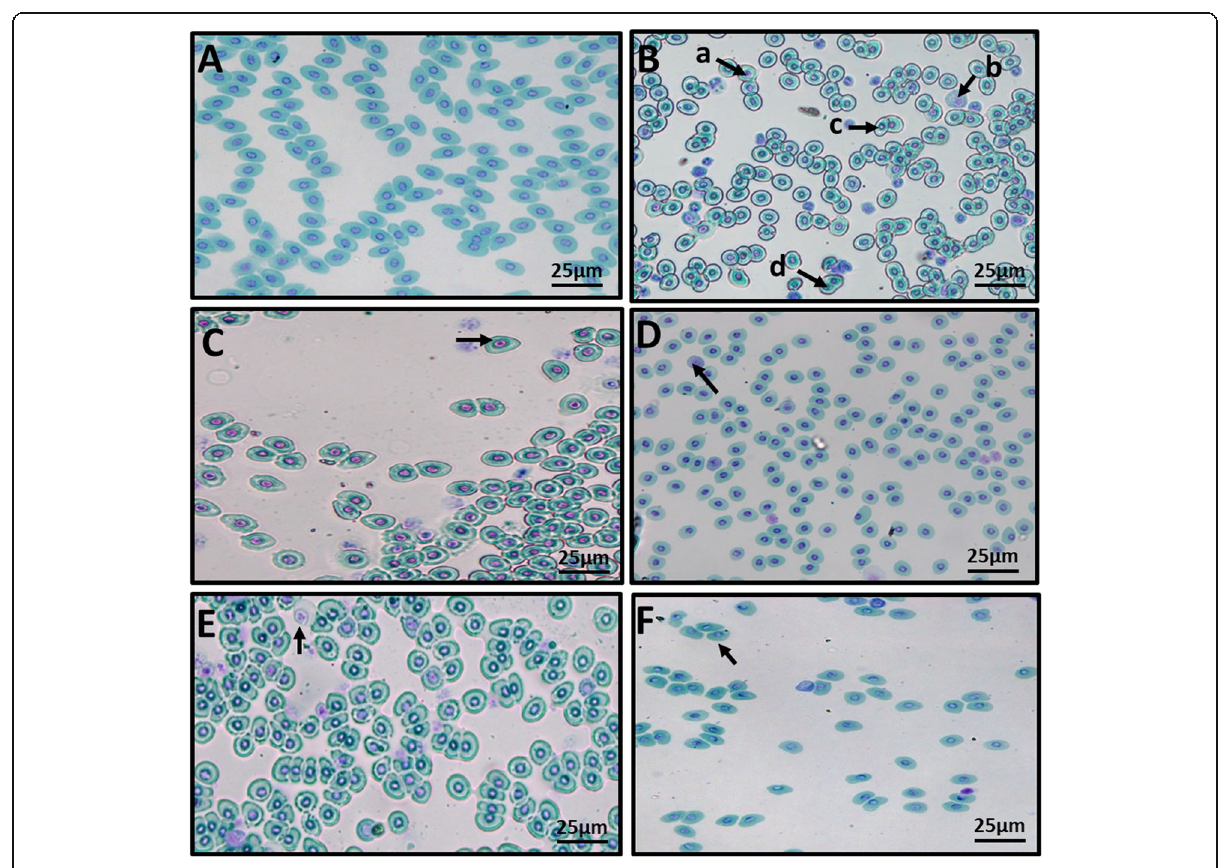
Fig. 8 Photomicrographs of blood smears of Heteropneustes fossilis after 8-day exposure to 0.015 ppm Envoy 50 SC. a Control — normal regular and systematic arrangement of nucleus of erythrocytes were found; b small nucleus (a), dead cell (b), fusion of cells (c), and binucleated cell (d); c tear-shaped cell; d ghost cell; e senile cell; and f abnormal shape of cells were